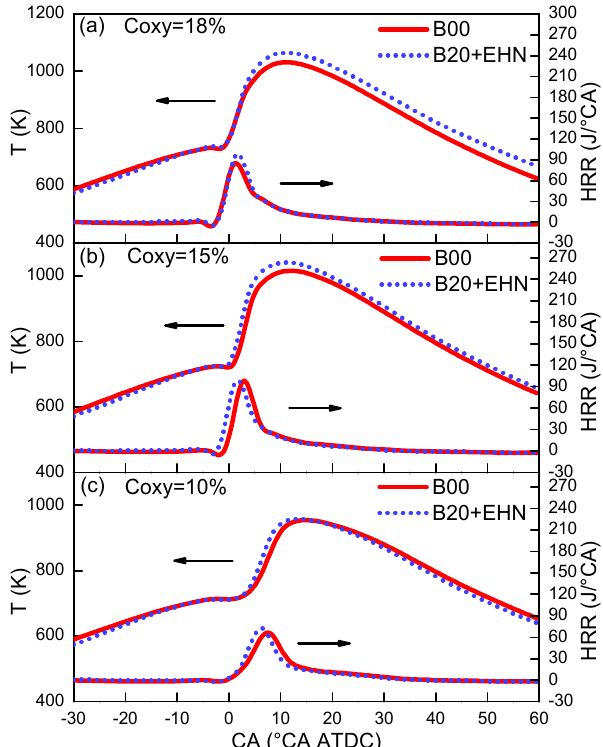
Figure 6. Average in-cylinder temperature and heat release rate at 18% ( a ), 15% ( b ), and 10% ( c ) intake oxygen concentrations.